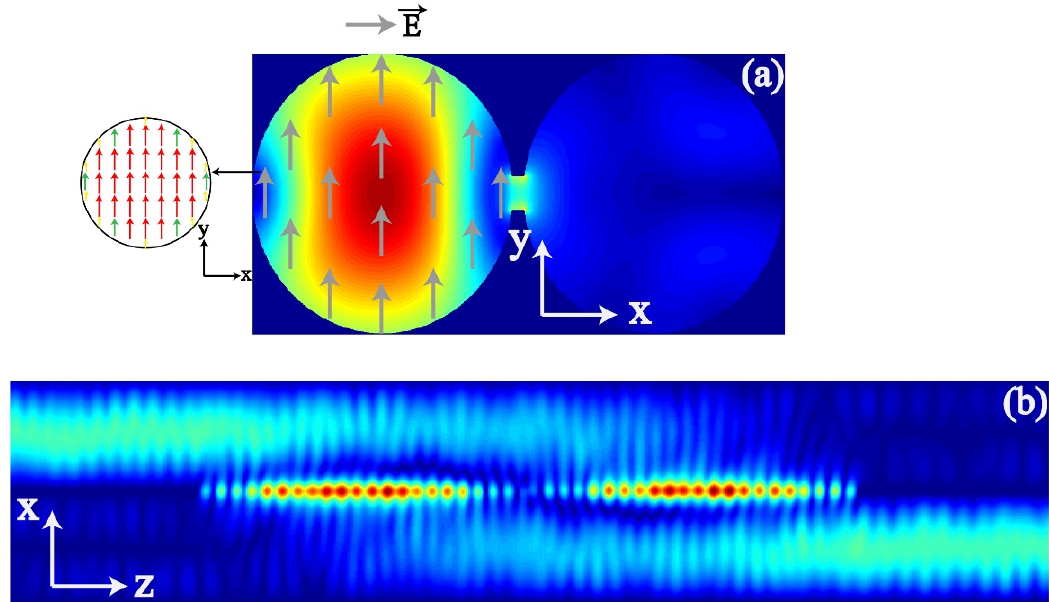
Figure 3. Vertical polarization wave inputting: ( a ) coupling slot structure direction and the transverse electric field and ( b ) longitudinal electric field (XZ cross section).